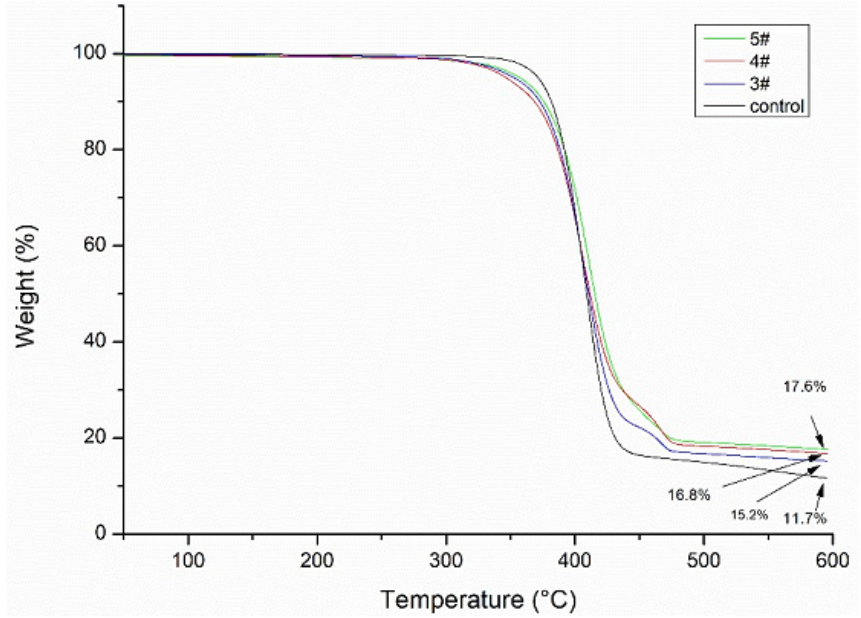
Figure 8. Thermogravimetric (TG) curves of control and ZnO/Ag composite coated polyester